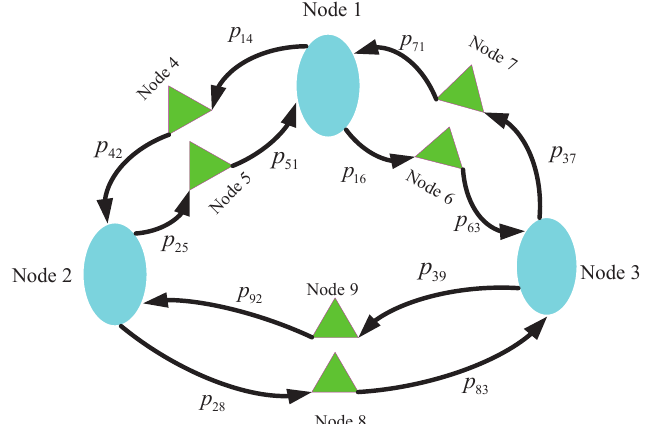
Figure 2. The physical structure of the three parking region dockless bike sharing system